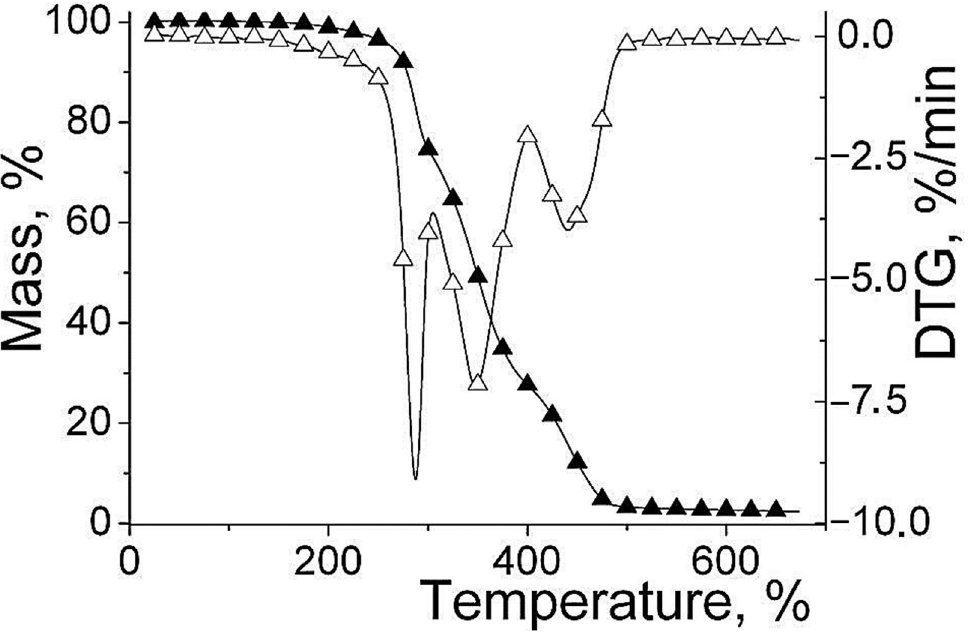
Figure 8. TG and DTG curves of PEBSA .